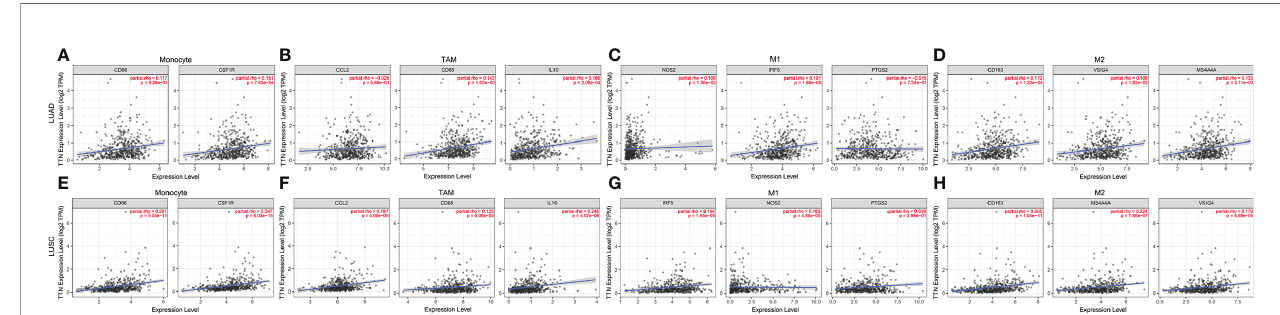
FIGURE 7 | TTN expression correlated with macrophage polarization in NSCLC. Scatterplots of correlations between TTN expression and gene markers of monocytes (A) , TAMs (B) and M1 (C) and M2 macrophages (D) in LUAD(n=515) (A – D) . Scatterplots of correlations between TTN expression and gene markers of monocytes (E) , TAMs (F) and M1 (G) and M2 macrophages (H) in LUSC(n=501) (E – H) .